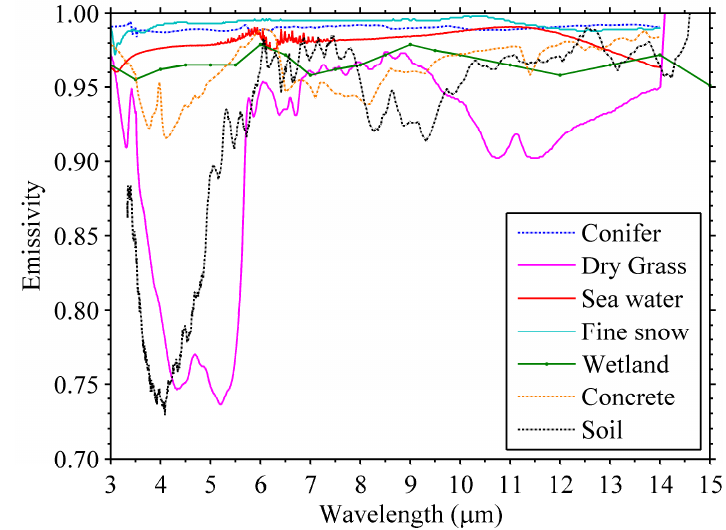
Figure 3. Spectral emissivity curves of seven surface types from ASTER used in MODTRAN simulation.